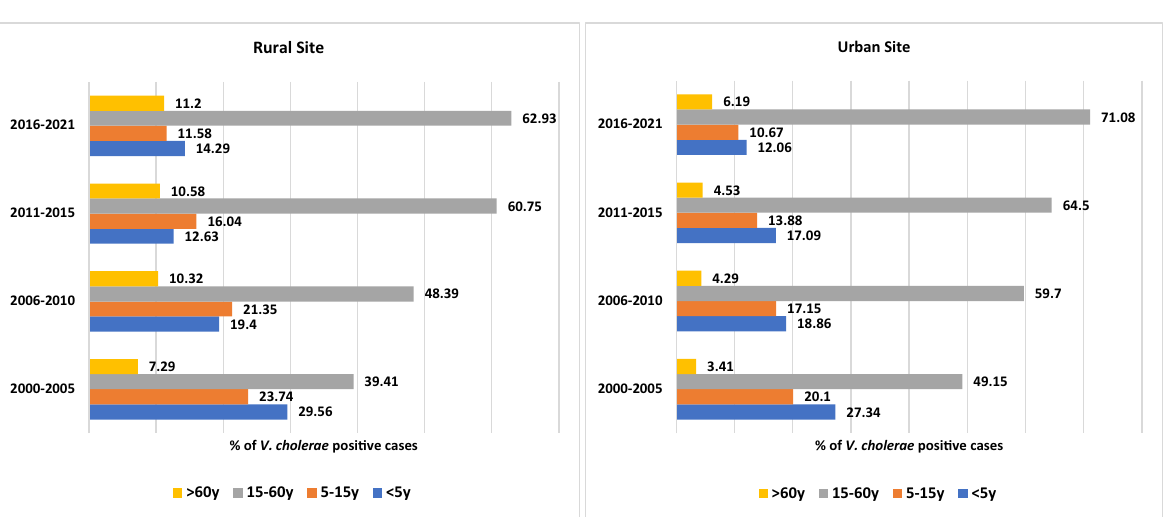
Figure 1. Age-specific distribution of V. cholerae positive patients admitted in the urban and rural sites during